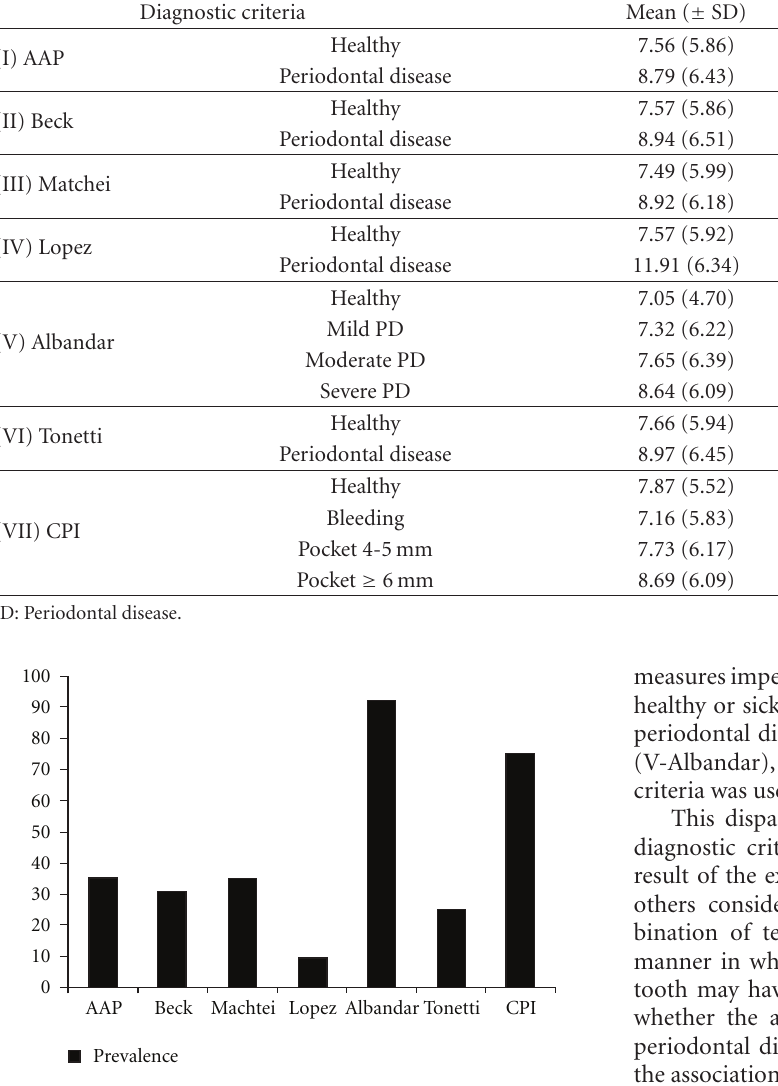
Figure 1: Prevalence of periodontal disease according to clinical diagnostic criteria. Belo Horizonte,